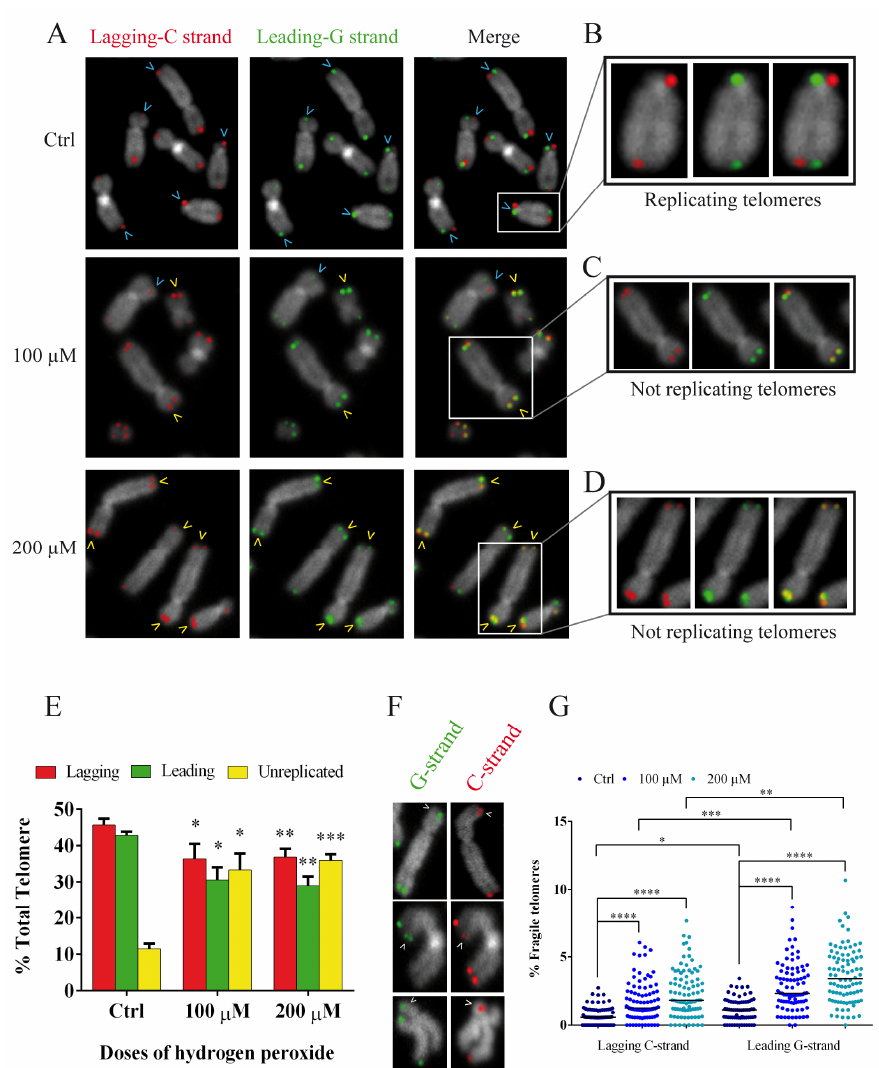
Figure 8. Chromosome Orientation-FISH to study replication at telomere. ( A ) Representative image of control and treated MRC-5 chromosomes, labeled by telomere-specific C- and G-rich probes. In detail red spots indicate the lagging C-strand, and green spots indicate the leading G-strand. The presence of both signals indicates unreplicated telomeres highlighted with yellow arrows, while blue arrows indicate replicated telomeres that displayed only one signal on each chromatid. Three enlarged chromosomes with replicated ( B ) and unreplicated telomere are shown to the right of the picture ( C – D ). The quantification of the % of replicated (both leading and lagging) and unreplicated telomeres is shown in the graph ( E ), demonstrating a significant decrease in replicated telomeres and an increase of unreplicated telomeres in 100 and 200 µM H 2 O 2 -treated samples with respect to the controls. The error bars denote the standard error. ( F ) Representative images of chromosomes with fragile sites for both the leading and lagging strands. The quantification of fragile telomeres is shown in ( G ), showing an increase in the percentage of fragile telomeres for the leading and lagging strands after treatment with both doses of hydrogen peroxide. The lines represent the median. Statistical analysis was performed between treated and control samples. * p < 0.05; ** p < 0.01; *** p < 0.001 by Student’s t